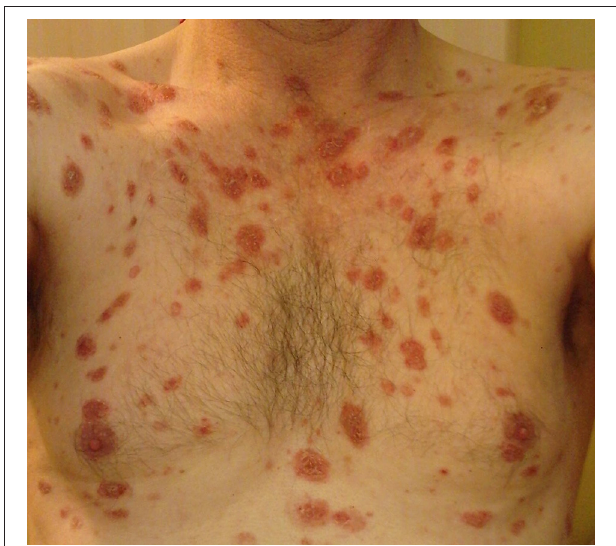
FIGURE 1 | Skin lesions before rituximab treatment.